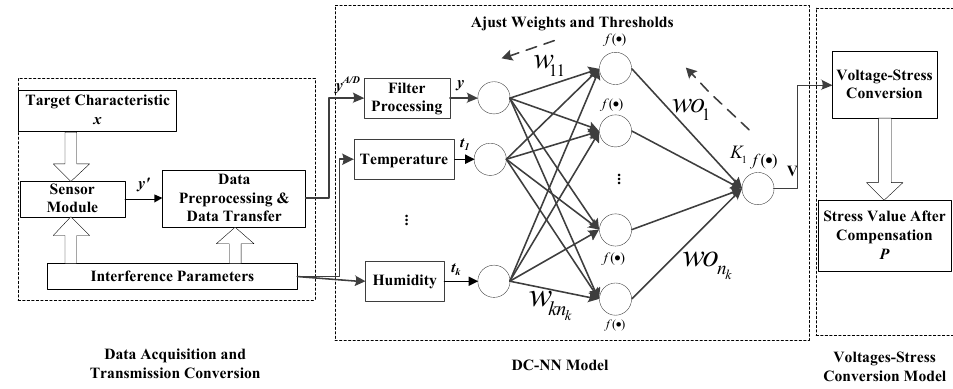
Figure 3. WSN acquisition data compensation framework.